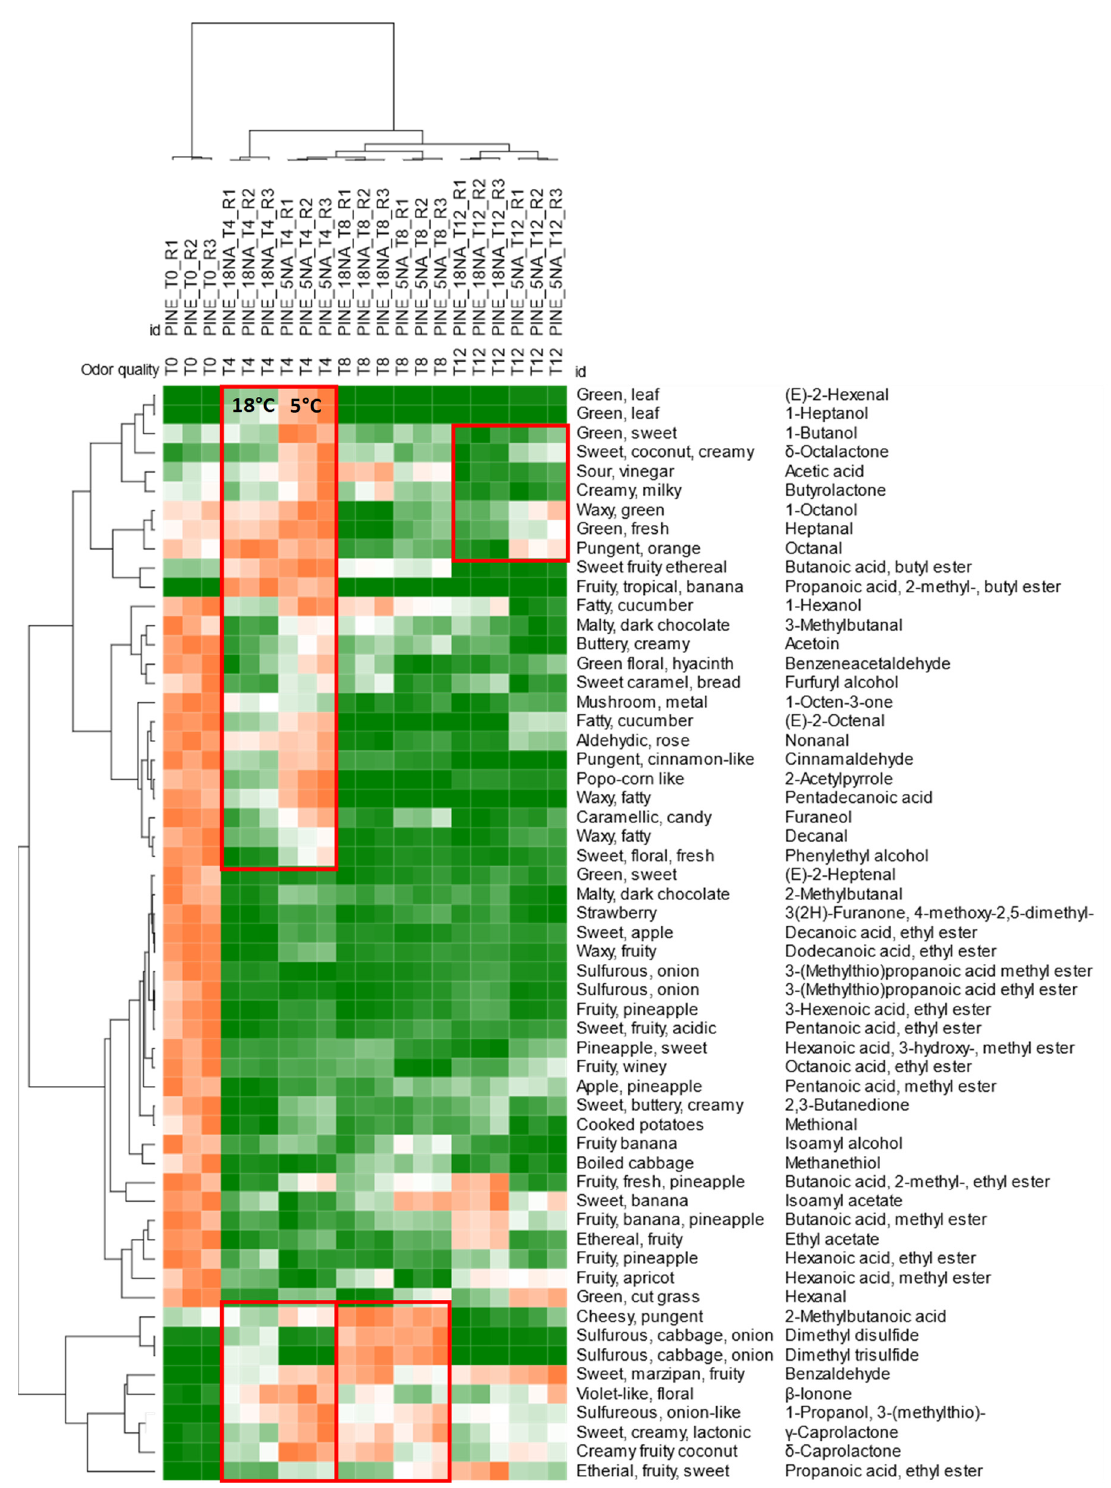
Figure 4. Heatmap visualization of normalized responses for potent odorants in dried pineapple samples. Hierarchical clustering is based on Pearson correlation after Z-score normalization.